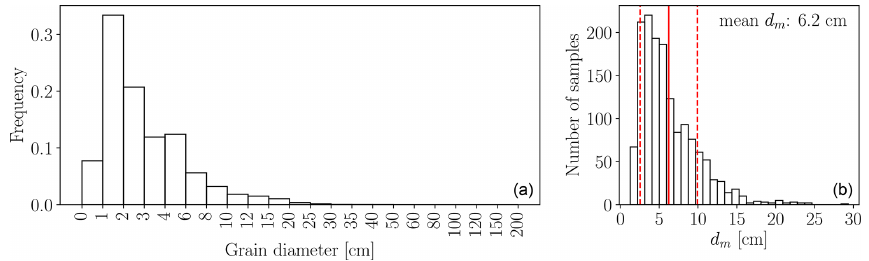
Figure 5. Overview of the ground truth data. (a) Average of the 1491 relative frequency distributions; (b) histogram of the respective characteristic mean diameter d m . The solid red line corresponds to the mean d m , and the dashed red lines correspond to mean ±